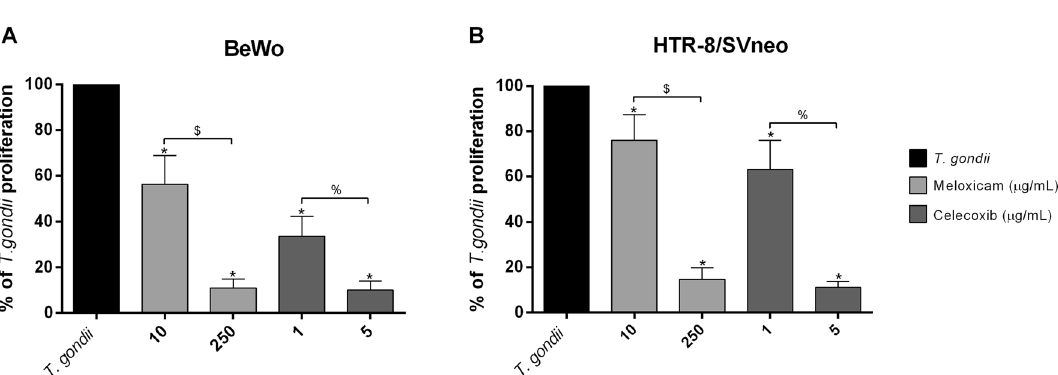
Figure 1. Cellular viability in BeWo and HTR-8/SVneo cells treated with COX-2 inhibitors. BeWo ( A ) and HTR-8/SVneo ( B ) cells were treated with meloxicam or celecoxib in increasing concentrations, or untreated (medium) or treated with 0.005% DMSO. After 24 h, the cells were submitted to MTT assay and data were presented as percentage (%) of viable cells (cellular viability) in relation to untreated cells (medium, 100% of cellular viability). Data were shown as mean ± SEM from three independents experiments with eight replicates. Differences between groups were analyzed by Kruskal–Wallis test and Dunn’s multiple comparison post-test (GraphPad Prism Sofware version 6.01, https:// www. graph pad. com). Differences were considered significant when P < 0.05.